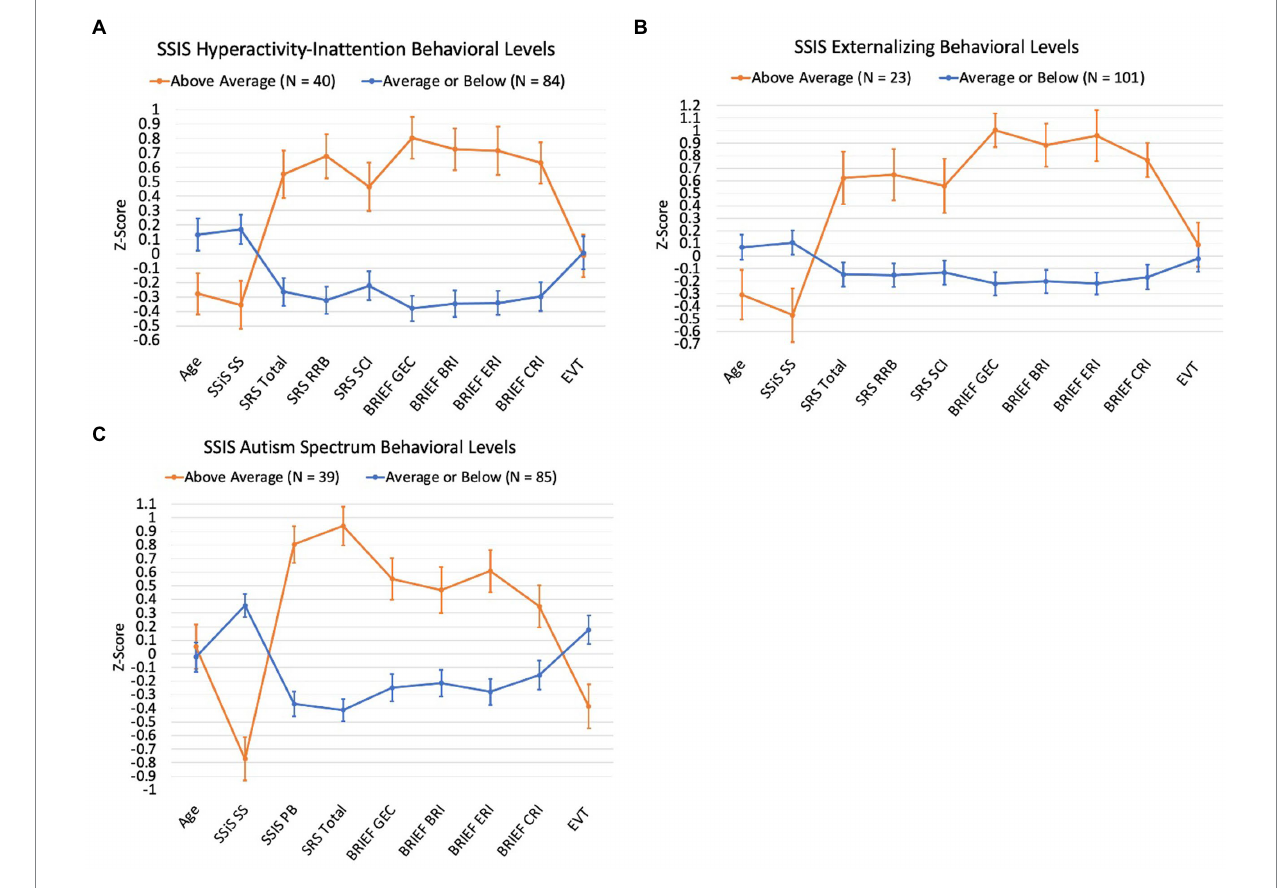
FIGURE 4 Participant scores across study measures by SSiS Problem Behaviors and Autism Spectrum subscale behavioral